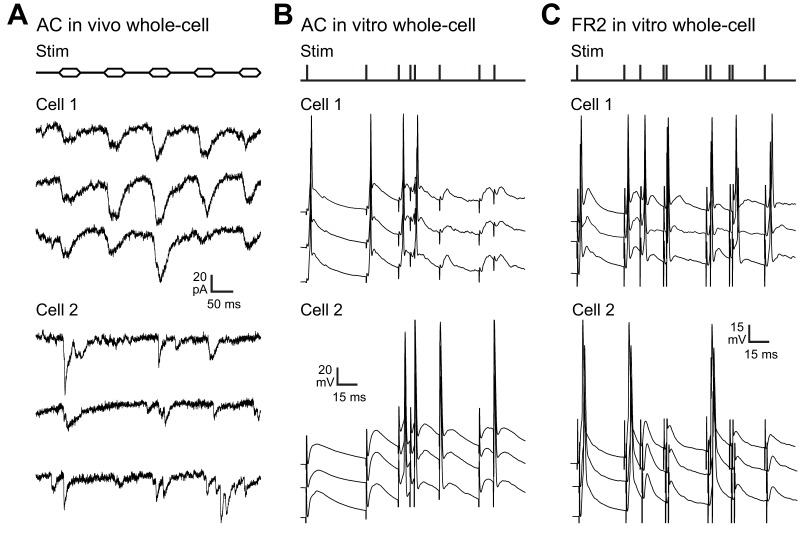
Whole-cell recordings from AC and FR2 neurons showing that different cells can have distinct responses to the same input pattern- necessary for ISI-based decoding by biological networks.In each case, note the reliability of response across trials but differences in response patterns across cells. (A) Two of eight in vivo whole-cell recordings from anesthetized adult rat primary AC, presenting trains of pure tones at the best frequency for each cell (top, ‘Stim’). (B) Two of nine whole-cell recordings from adult rat AC in brain slices. Extracellular stimulation was used to present input patterns previously recorded from cortex with tetrode recordings in behaving rats during the auditory task used here, and responses recorded in current-clamp near spike threshold. (C) Two of 11 whole-cell recordings from adult rat FR2 in brain slices.